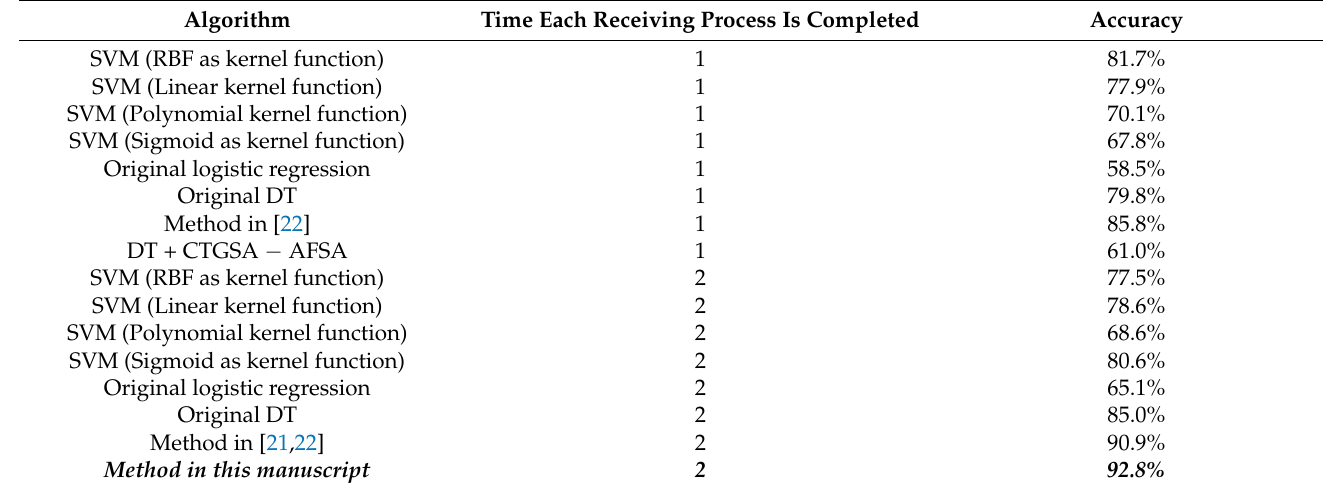
Table 2. Accuracy comparisons of each method under static NLOS situations.